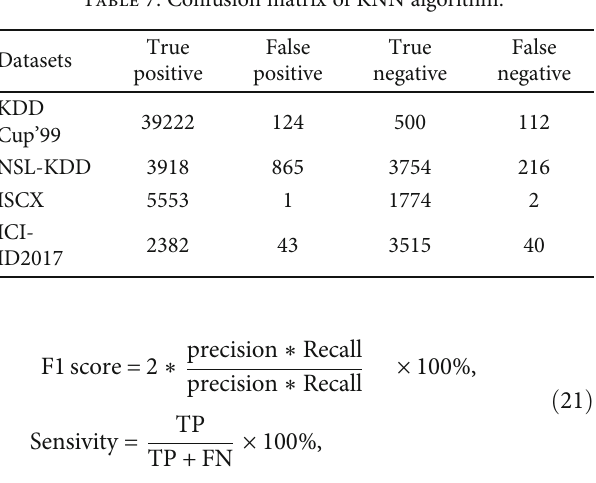
Table 7: Confusion matrix of KNN algorithm.